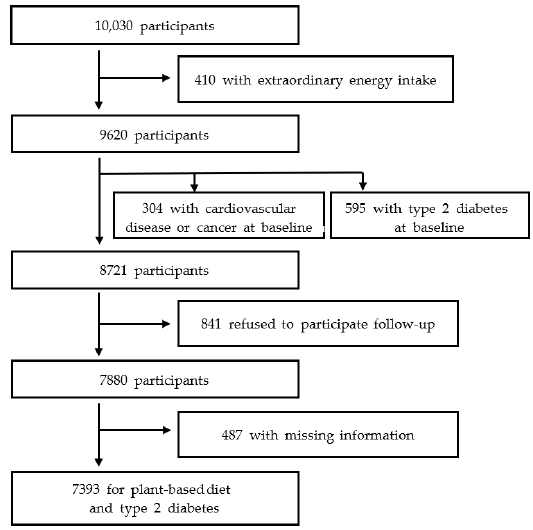
Figure 1. Flow diagram of participant selection.